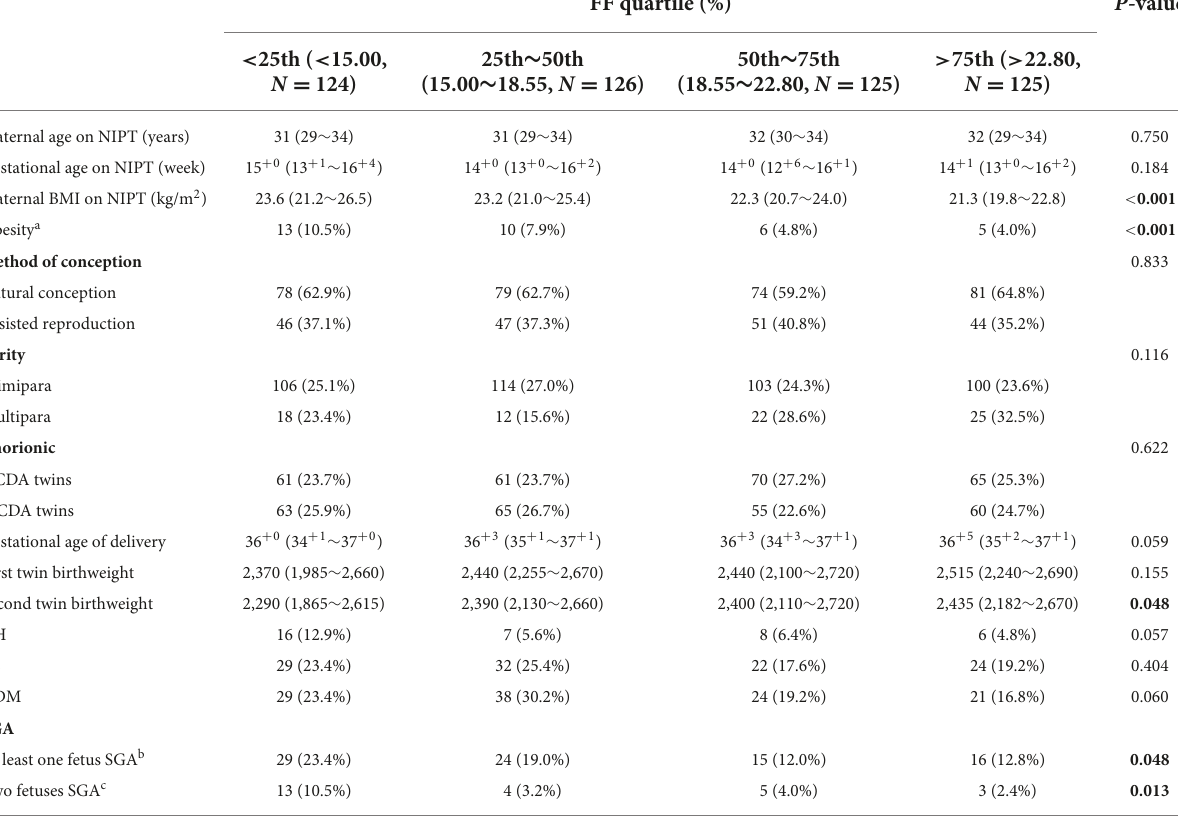
TABLE 1 Baseline demographic characteristics of pregnant women on NIPT in the study cohort based on the categories of FF ( n = 500). FF quartile (%)